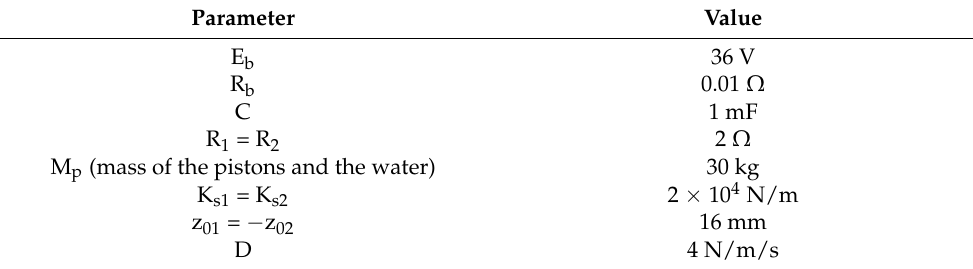
Table 1. The parameters of the motor. Parameter